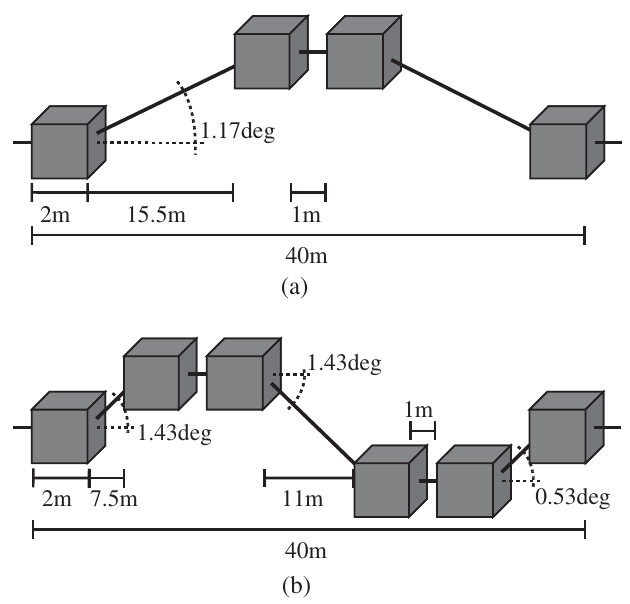
FIG. 13. Optimized geometries of the C-chicane (a) and the S- chicane (b).